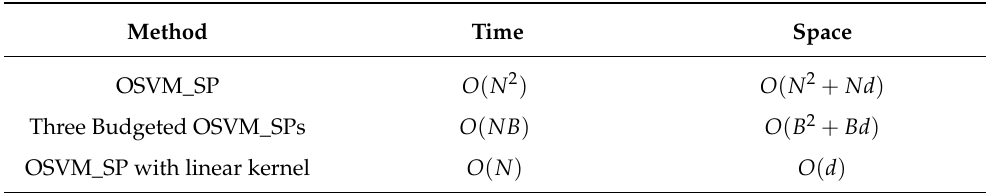
Table 1. Computational complexity of the proposed